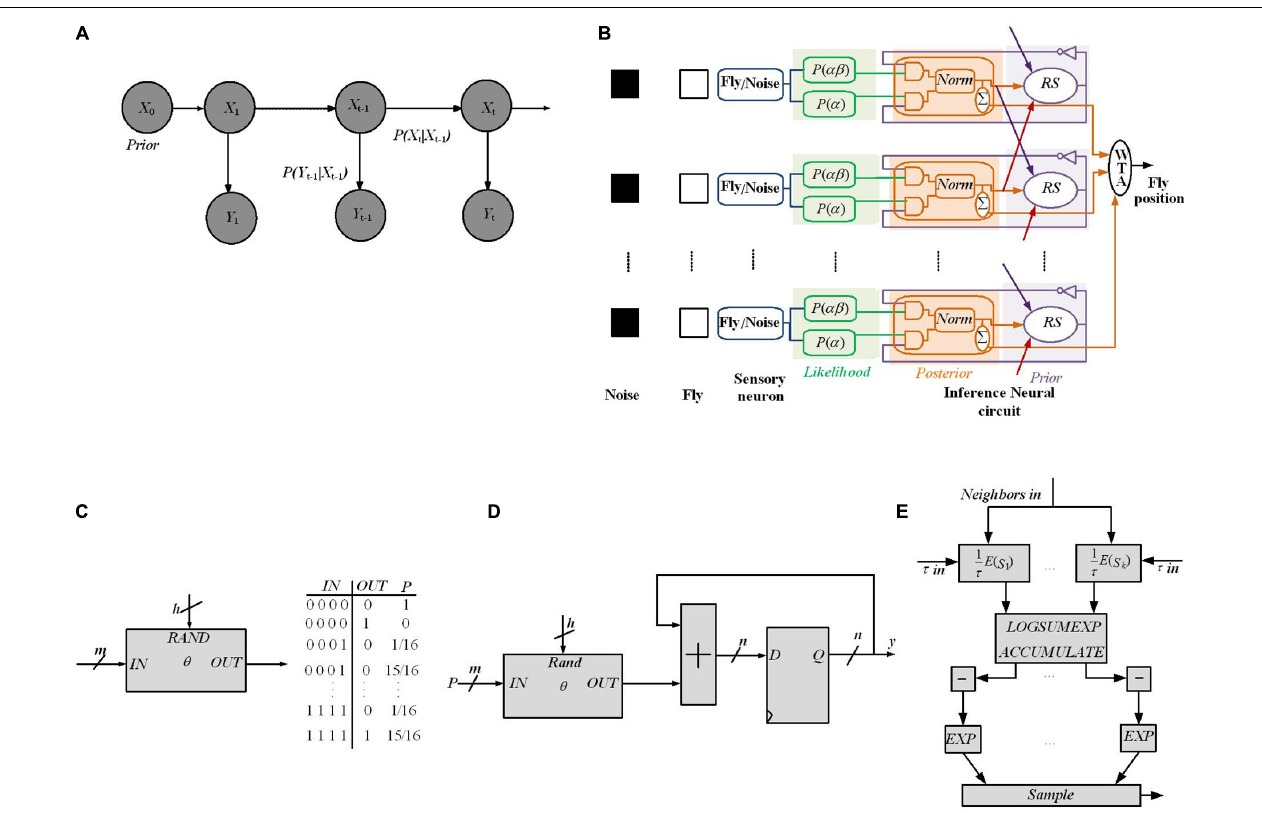
FIGURE 8 | FPGA implementation of different Bayesian networks (A) An HMM architecture, in which the random variables X t and Y t are the hidden state at time t and the observation at time t , respectively (conditional dependencies are shown by arrows). (B) Digital Hardware implementation of HMM algorithm for Bayesian inference in Thakur et al. (2016). Implement the Gibbs sampling algorithms for Markov random fields in Mansinghka et al. (2008). (C) The schematic and CPT for a O gate, which flips a coin by specifying the weight on IN as a binary number [e.g., for IN = 0111, P ( OUT = 1| IN ) = 7/16]. A comparator that outputs 1 if RAND ≤ IN has been employed for implementing the O gate. (D) The proposed circuit for sampling, for a binomial distribution, utilizes nh bits of entropy to perform sampling while considering n flips of a coin of weight. (E) Gibbs pipeline, for Gibbs sampler depicting the required operations to numerically sample an arbitrary-size